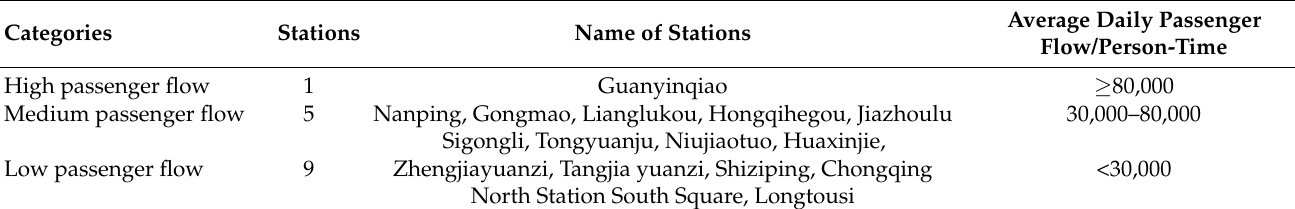
Figure 7. Clustering results after executing K-means algorithm. In the figure, red circles represent low passenger flow stations, blue circles represent medium and high passenger flow stations, and asterisks represent clustering centers. Table 1. Cluster analysis results of some stations of Chongqing Rail Transit Line 3.